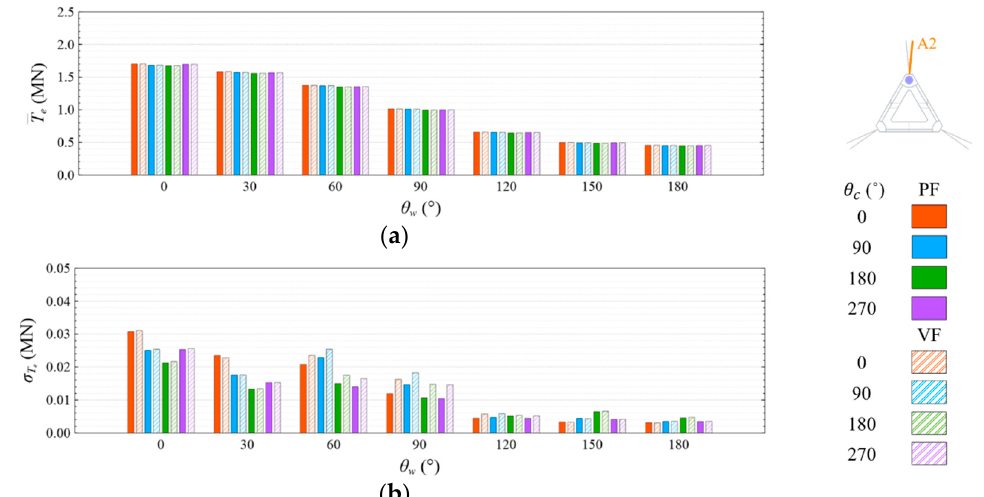
Figure 29. Comparison of ( a ) means and ( b ) standard deviations of mooring line tension of Line A2 under CW condition.